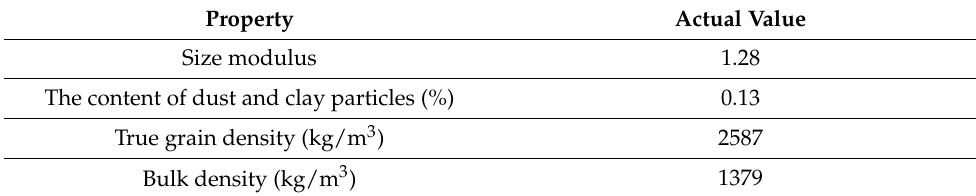
Table 6. Characteristics of